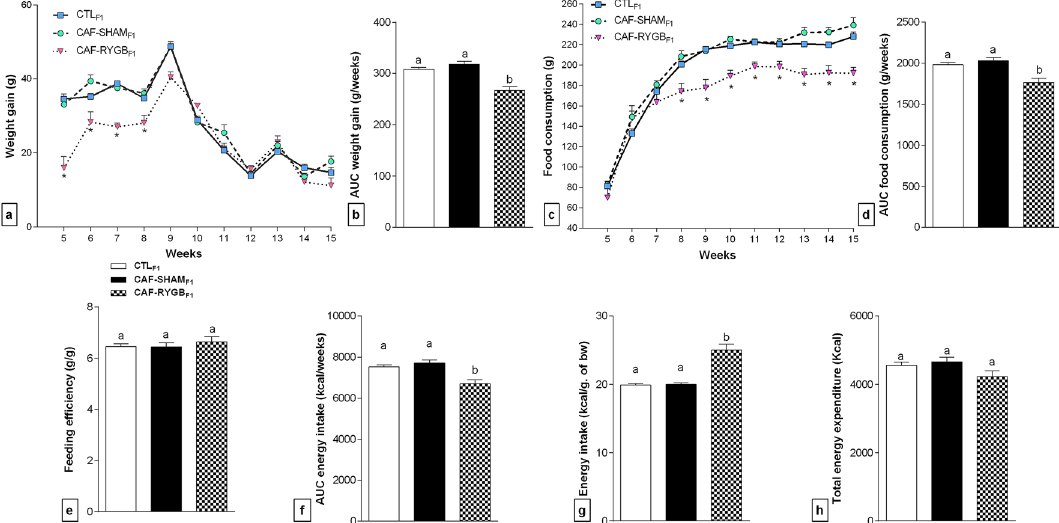
Figure 2. Metabolic parameters in offspring from dams submitted, or not, to RYGB. CTL F1 , offspring of rats fed standard diet (n = 36 animals); CAF-SHAM F1 , offspring of rats fed on CAF diet and submitted to sham operation (n = 28 animals); CAF-RYGB F1 , offspring of rats fed on CAF diet and submitted to RYGB (n = 14 animals). Weight gain ( a ) and food intake ( c ) were measured weekly. Metabolic parameters were analysed and presented, by AUC, the weight gain ( b ), total food consumption ( d ), feeding efficiency ( e ), total energy intake ( f ), energy intake per gram of body weight ( g ) and total energy expenditure ( h ). Different letters indicate statistical differences by one-way ANOVA and Bonferroni post-test ( p < 0.05). The data are mean ± SEM. * p <